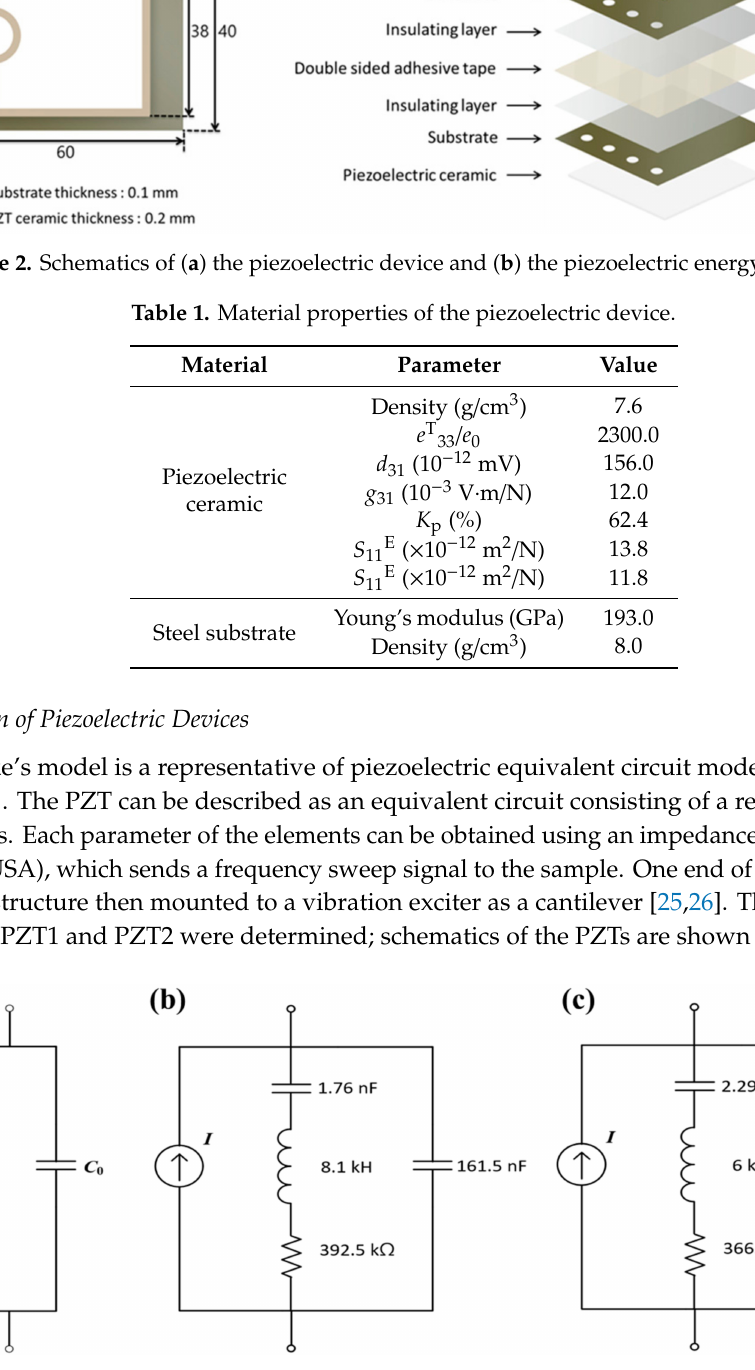
Figure 3. Equivalent circuit of the lead zirconate titanate (PZT): ( a ) Van Dyke’s model. Equivalent circuits of ( b ) PZT1 and ( c )